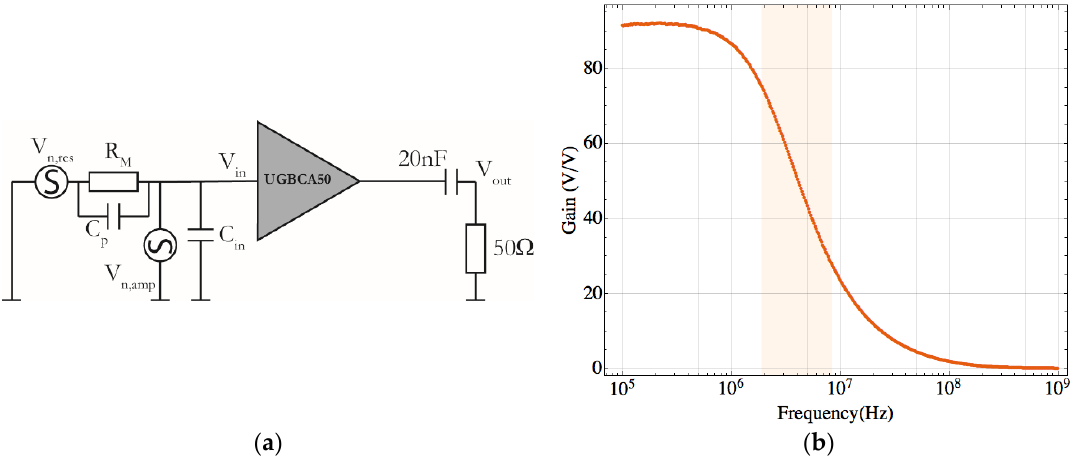
Figure 5. ( a ) E quivalent circuit for noise analysis of the CMOS capacitive readout circuit. 𝑉 𝑛,𝑟𝑒𝑠 = (4𝑘 𝐵 𝑇𝑅 𝑀 ) 1/2 represents the resonator thermomechanical noise voltage per unit of bandwidth root square, and 𝑉 𝑛,𝑎𝑚𝑝 is the corresponding input-referred voltage noise of the CMOS circuit. ( b ) Plot of the simulated voltage gain for the UGBCA50 amplifier. The operation region, where the gain decreases with the frequency, is highlighted in light orange.